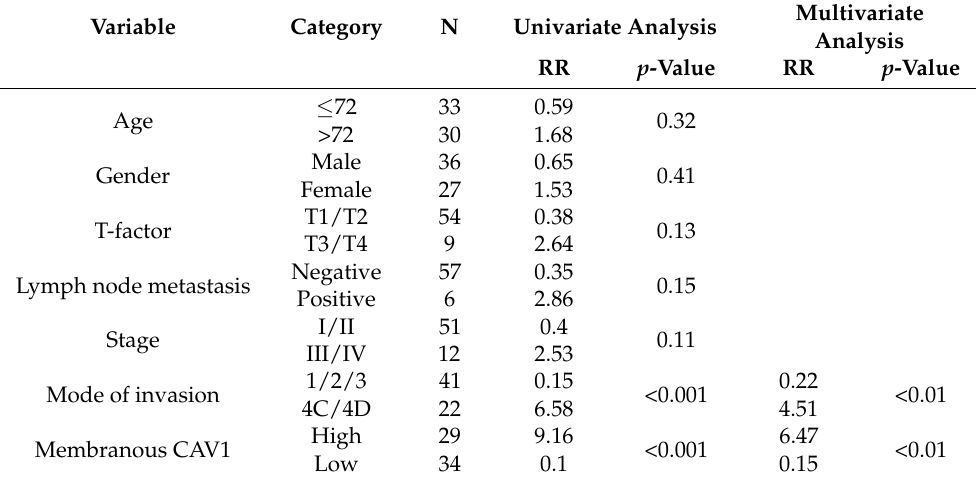
Table 2. Univariate and multivariate analyses of clinicopathological parameters and membranous CAV1 expression in relation to relapse-free survival in